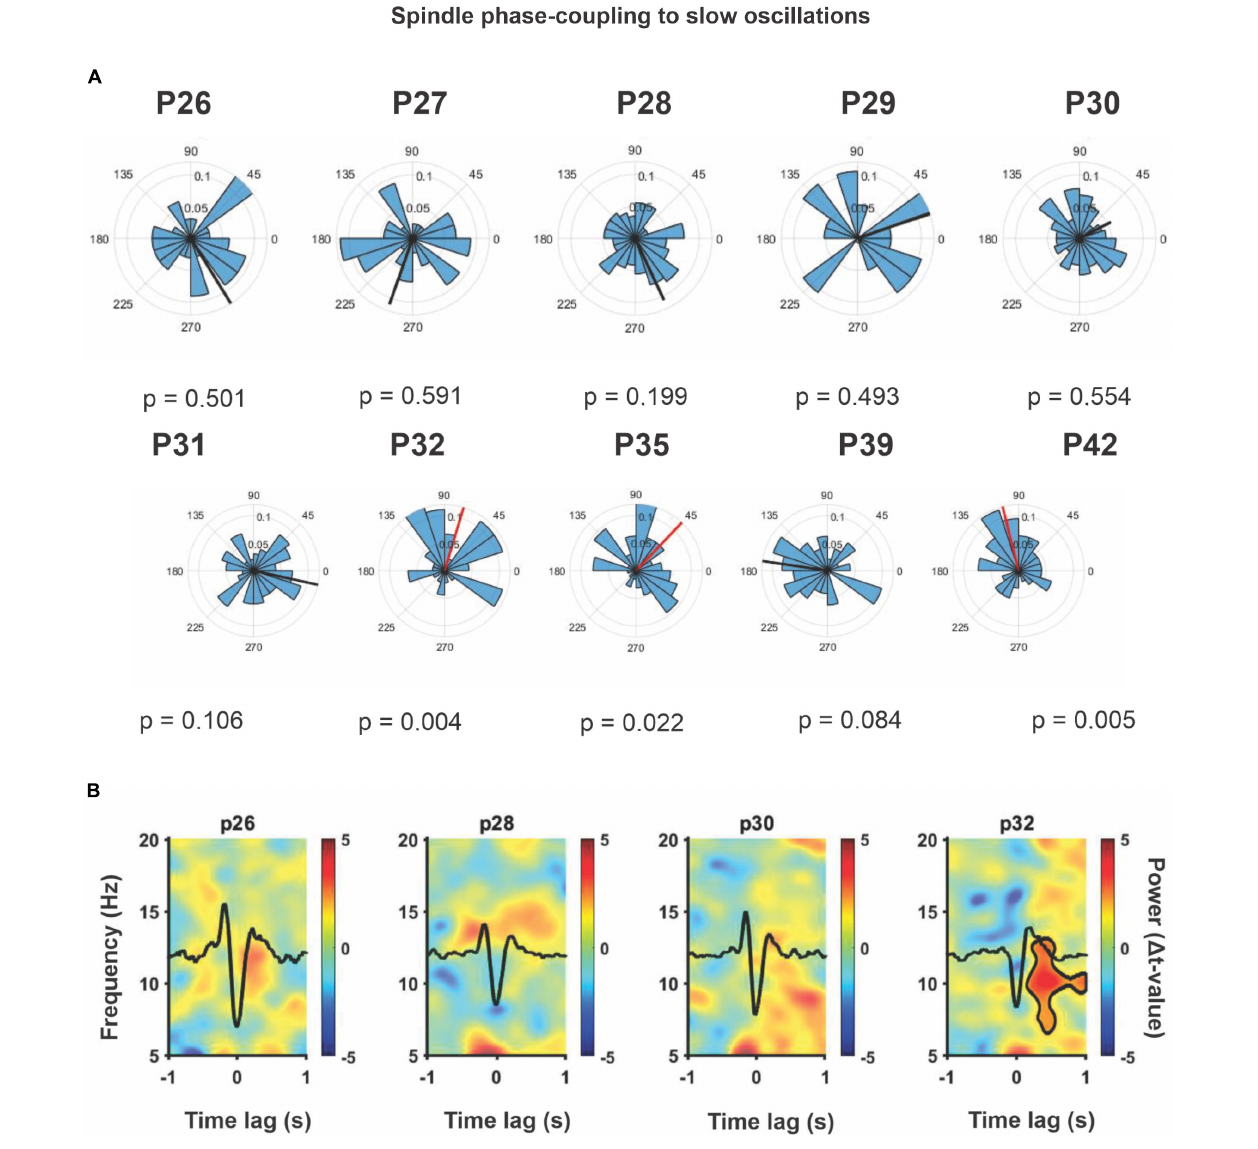
FIGURE 8 | Spindle phase-coupling to slow oscillations. (A) Polar histograms across the postnatal day from P26 to P42 ( n = 4). The resulting vector represents the mean direction and length for each case. The threshold for significant directionality was set at p = 0.05 (Rayleigh’s test for non-uniformity), significant is shown in red, otherwise in black. The 90 ◦ corresponds to the peak of the SO event (up-state) and 270 ◦ to the SO-trough (down-state). A significant directionality was detected at P32, P35, and P42. Spindle showed a preferent coupling distribution with the up-state of the SO ( p = 0.022 or lower). (B) SO-triggered Spindle average spectrogram from cortical LFPs. SO down-state centered at 0 ± 1 s time lag. At P32, a significant power increase was observed in the Spindle frequency range (9–17 Hz) around the up-state of the SO. Statistical comparisons were performed through a non-parametric permutation test (MonteCarlo, n = 1000) using a cluster alpha of 0.02 and with a significance mask of p < 0.01. A significant cluster at P32 ( p < 0.01) was indicated with a black